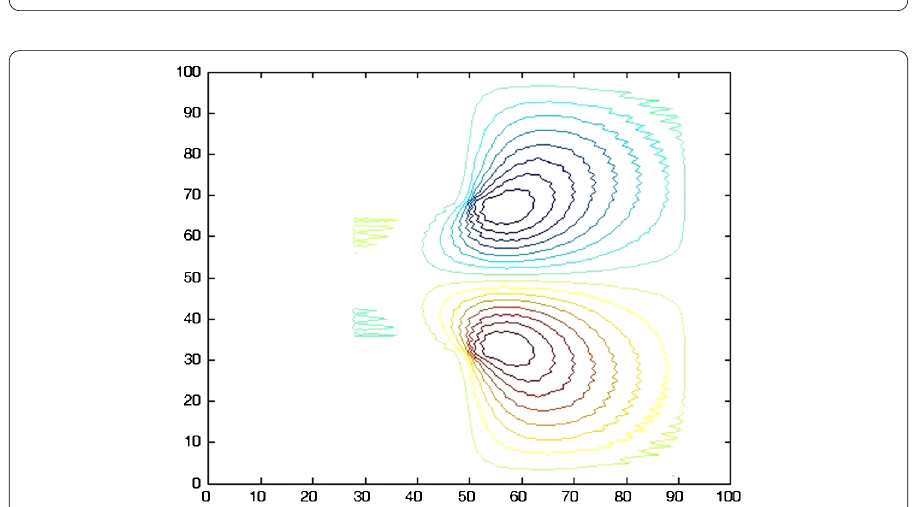
Figure 4 The component F 12 of the SMFE solution of the deformation tensor F at t = 10.